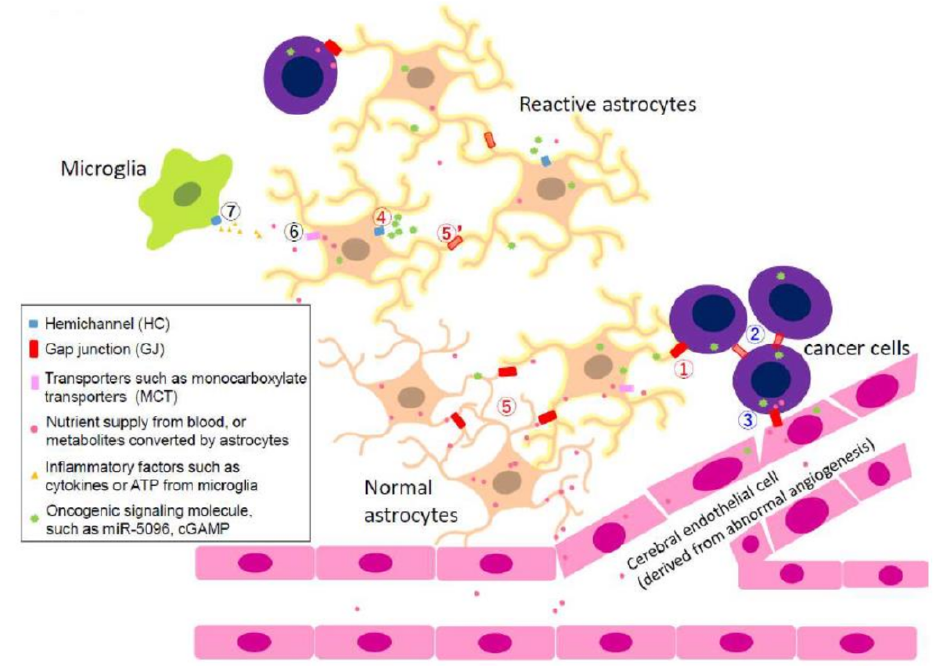
Figure 1. The microenvironment of glioma or metastatic cancers in central nerve system (CNS). Reactive astrocytes have increased Cx43 and GFAP levels, while PTEN, a well-known tumor suppressive protein, is decreased. Cerebral endothelial cells (CECs) also participated here as angiogenesis inducing factor and supply nutrients. Microglia increases glucose uptake by astrocytes. Numbers in circle indicate GJ or HC pathways to maintain this environment. Red colored pathways ( 1 , 4 , 5 and 5 (cid:48) ) are common between glioma and metastatic cancers. Blue colored pathways ( 2 and 3 ) are derived from previous reports on glioma (84,101). Black colored pathways ( 6 and 7 ) denotes those around reactive astrocyte in inflammatory condition [3]. Pathway 1 : GJ between a cancer cell and an astrocyte; it promotes tumor invasion by transferring oncogenic signaling molecules from a cancer cell to an adjacent astrocyte. Pathway 2 : GJ between glioma cells; down-regulation of GJ promotes invasion of glioma. Pathway 3 : GJ between glioma and CEC; it promotes angiogenesis. Pathway 4 : HC activity of reactive astrocyte; it contributes to spreading of oncogenic signaling molecule in the brain. Pathway 5 : GJ between normal astrocytes; it supports nutrients supply from CECs to CNS cells. Pathway 5 (cid:48) : GJ between astrocytes located distal from the tumor; it is mainly down-regulated when HC is upregulated. Pathway 6 : Transporters expressed in astrocytes located distal from the tumor; they are believed to be upregulated to uptake enough metabolites. Pathway 7 : HC activity in microglia; it may support increase of glucose uptake in astrocytes, while it decreases spread of glucose between